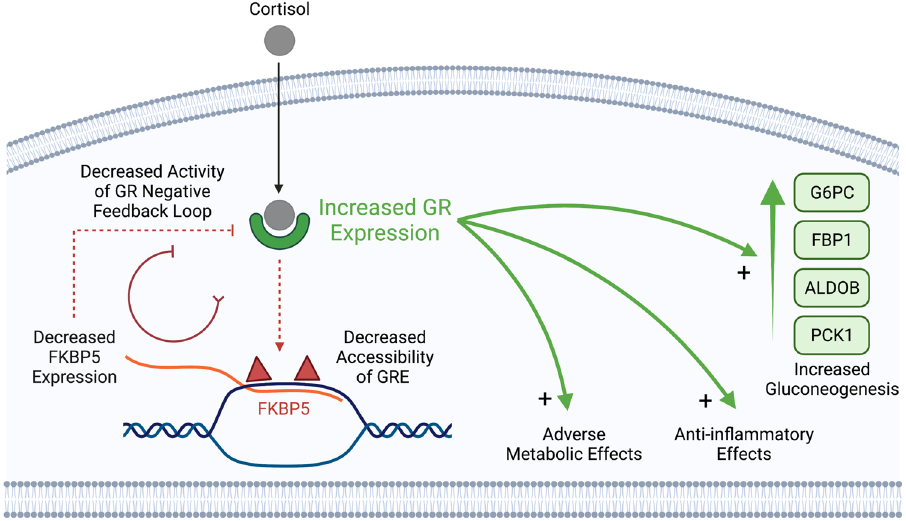
Fig. 8 | Model of altered glucocorticoid receptor signaling in the diabetic proximal tubule. GR expression is increased in the diabetic proximal tubule. Cortisol binds GR and translocates to the nucleus where it localizes to glucocorti- coid response elements (GRE) in genes like FKBP5 . Decreased chromatin accessi- bility of GRE in the FKBP5 gene body is observed as reduced accessibility of proximal-tubule-speci fi c ATAC peaks in DKD (red triangles). Reduced accessibility of FKBP5 GRE leads to reduced transactivation by GR and reduced